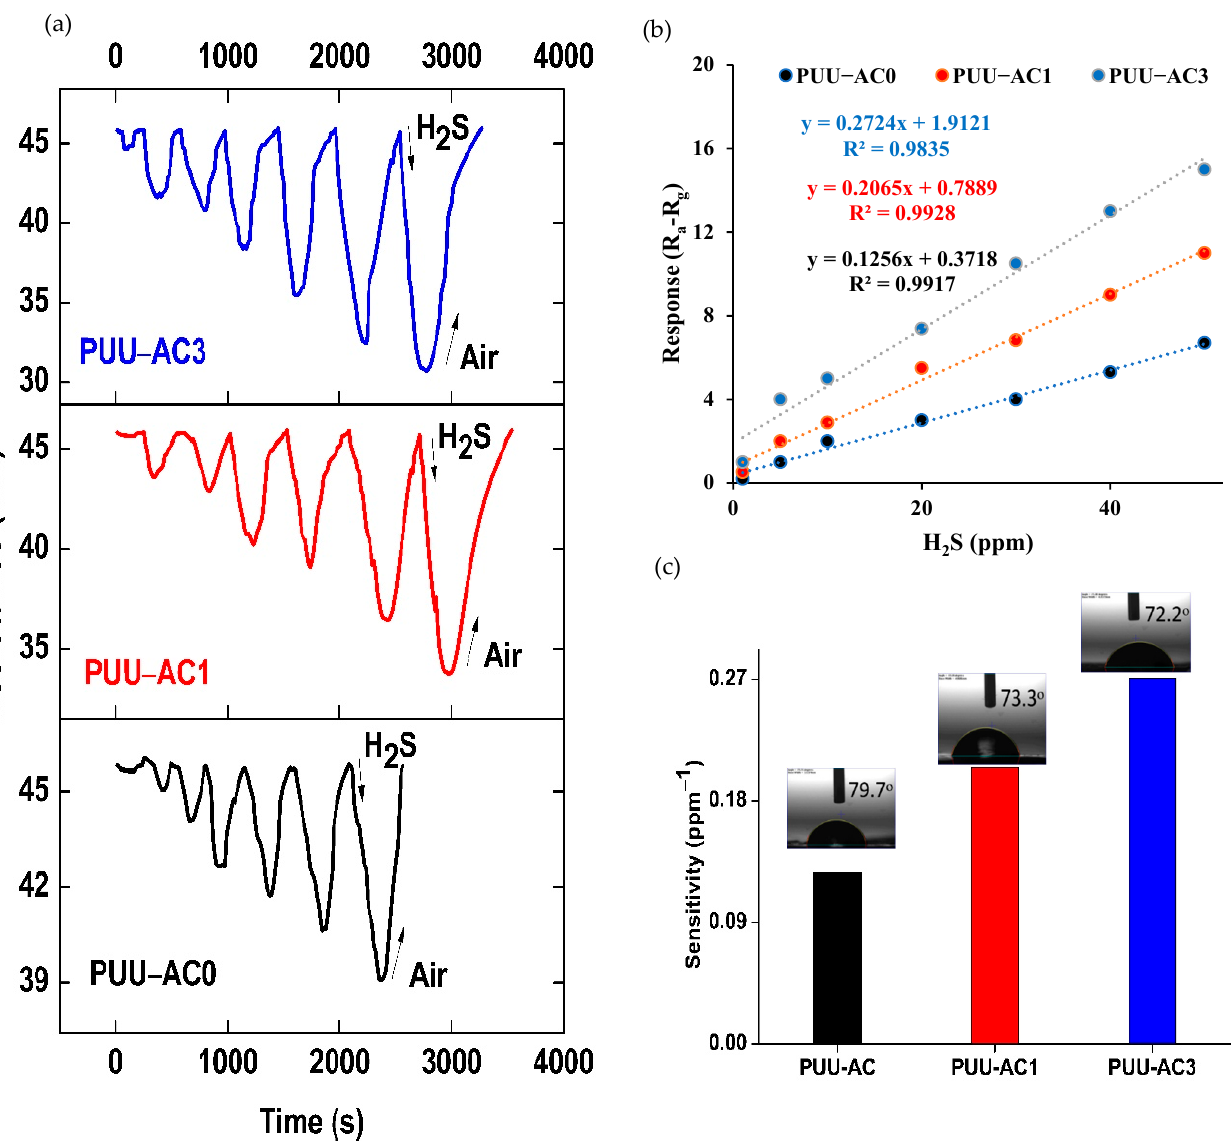
Figure 7. ( a ) Current-time transient responses of sensor PUU-AC0, PUU-AC1 and PUU-AC3 to different concentrations of H 2 S in a range of 50-1 ppm. ( b ) Response curves of PUU-AC0, PUU-AC1 and PUU-AC3 sensor to increasing concentrations of H 2 S in 60% RH (V = +1 V). ( c ) The sensor sensitivity values were reported in the bar plot with water contact-angle pictures of samples captured by microscope (inset).